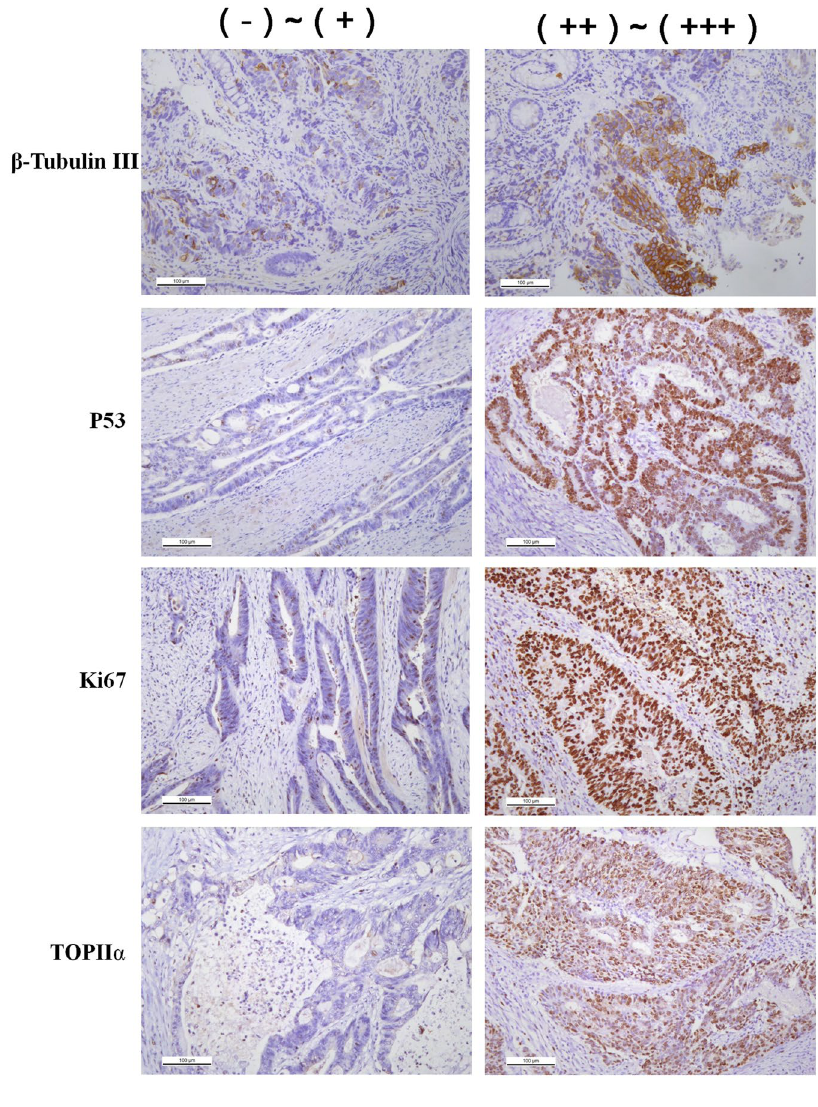
Figure 2. Representative images of different expression level of β -Tubublin III, P53, Ki67 and TOPII α in colorectal cancer ( ×